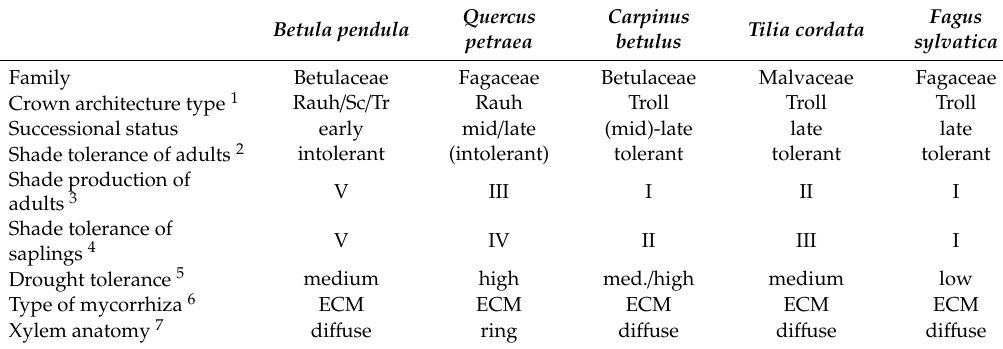
Table 1. Functional and morphological traits of the five tree species studied according to [14–20], and others.